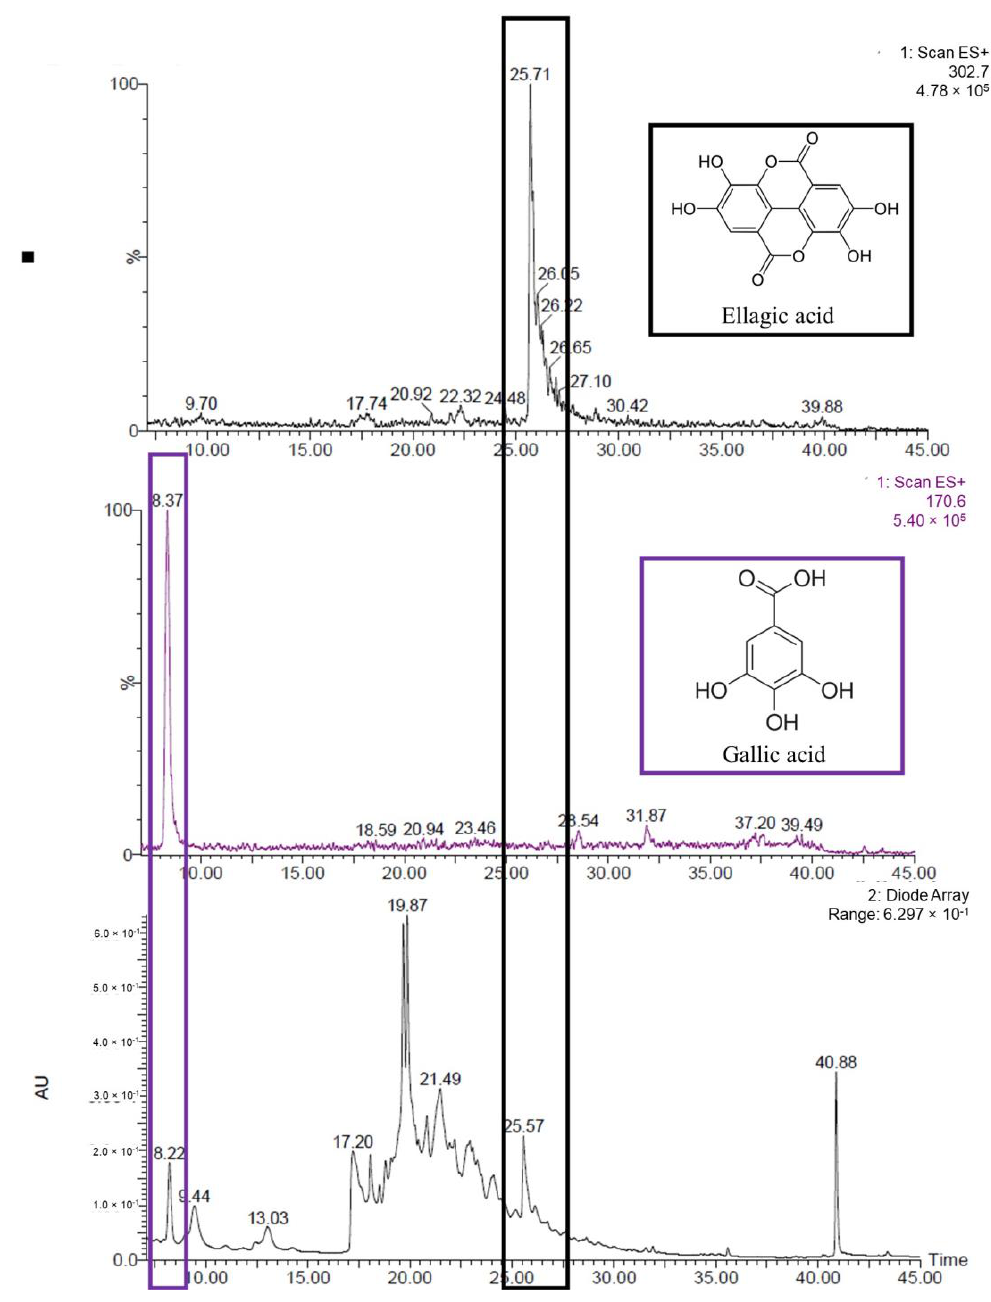
Figure 12. LC-MS analysis, detail for ellagic (m/z: 302) and gallic acid signals (m/z: 170). Masses are selected +0.5 m/z due to detector calibration.